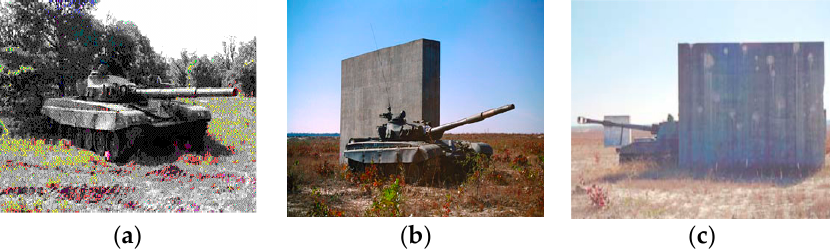
Figure 2. Examples of environment variation: ( a ) Target occluded by trees; ( b ) Target occluded by a wall; and ( c ) Target occluded by a wall from another